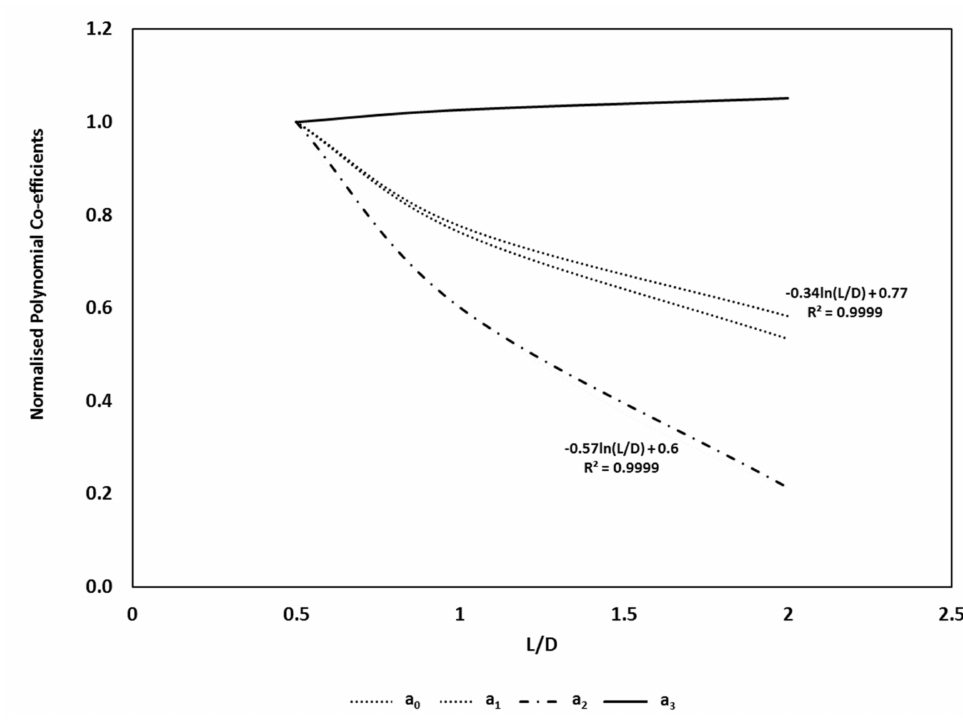
Figure 9. Variation of the polynomial coefficients with L/D.